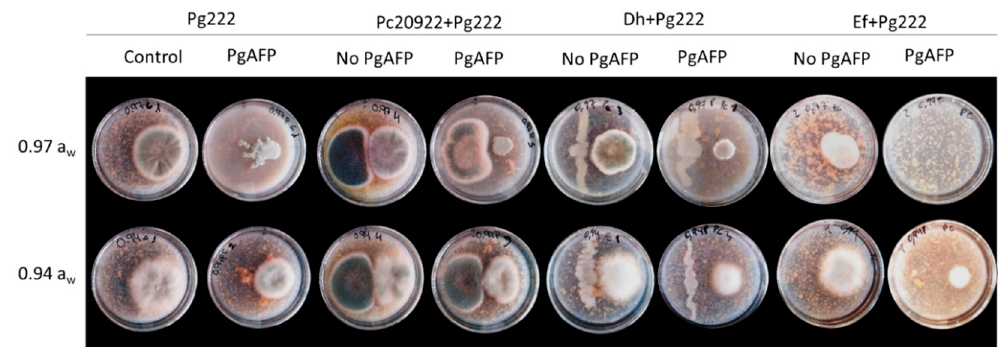
Figure 3. Interactions of the three biocontrol agents ( Enterococcus faecium SE920, Debaryomyces hansenii FSHCC 253H, and Penicillium chrysogenum CECT 20922) with native dry-cured meat product mold P. chrysogenum FSHCC Pg222 at 0.97 and 0.94 water activity ( a w ) after 7 days at 25 °C in the presence and absence of the antifungal protein PgAFP in dry-cured fermented sausage (salchichón)-based medium. Treatments: Control: P. chrysogenum FSHCC Pg222 inoculated without biocontrol agents; Pg222: P. chysogenum FSHCC Pg222; Pc20922: P. chrysogenum CECT 20922; Dh: D. hansenii FSHCC 253H; Ef: E. faecium SE920. No PgAFP: PgAFP was not added; PgAFP: PgAFP was added. The biocontrol agent was inoculated on the left side of the plate and P. chrysogenum FSHCC Pg222 on the right side of the plate.